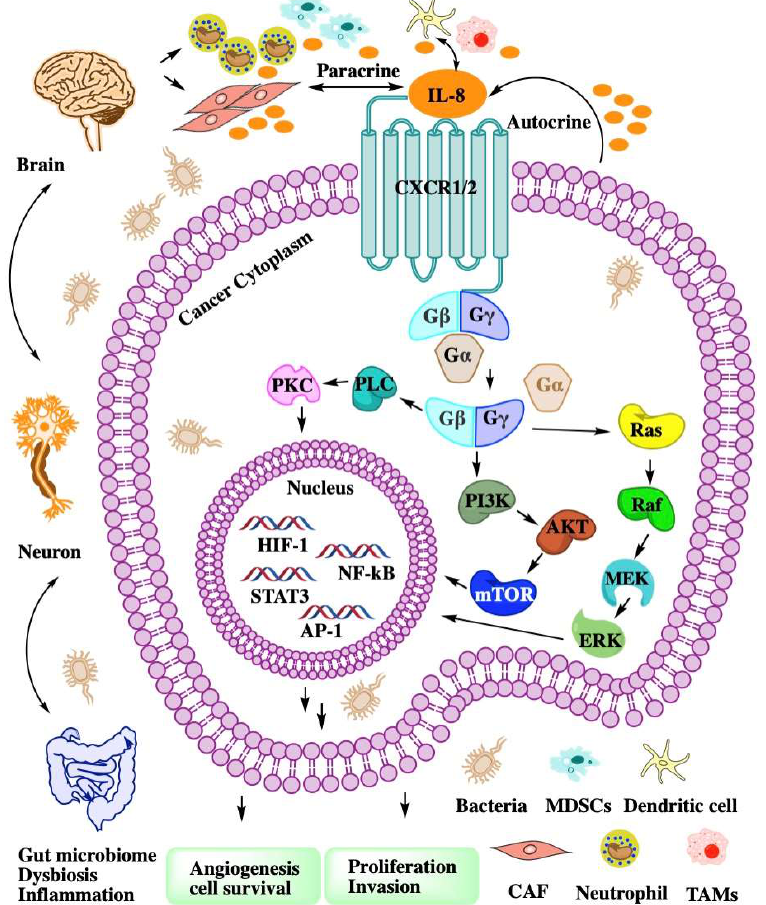
Figure 2. The intricate network of the CXCL8-CXCR1/2 axis in TME. CXCL8 binding to CXCR1/2 activates G-protein-mediated signaling cascades in cancer cell. CXCR1/2 activation leads to the dissociation of the Gα subunit from the Gβγ subunits. The signal of Gβγ subunits activate kinase to enhance angiogenesis, proliferation, and invasion. Cancer cell autocrine CXCL8 to recruit MDSCs or neutrophil to TME. Dysbiosis or inflammation affects myeloid cell recruitment through the gut– brain axis.